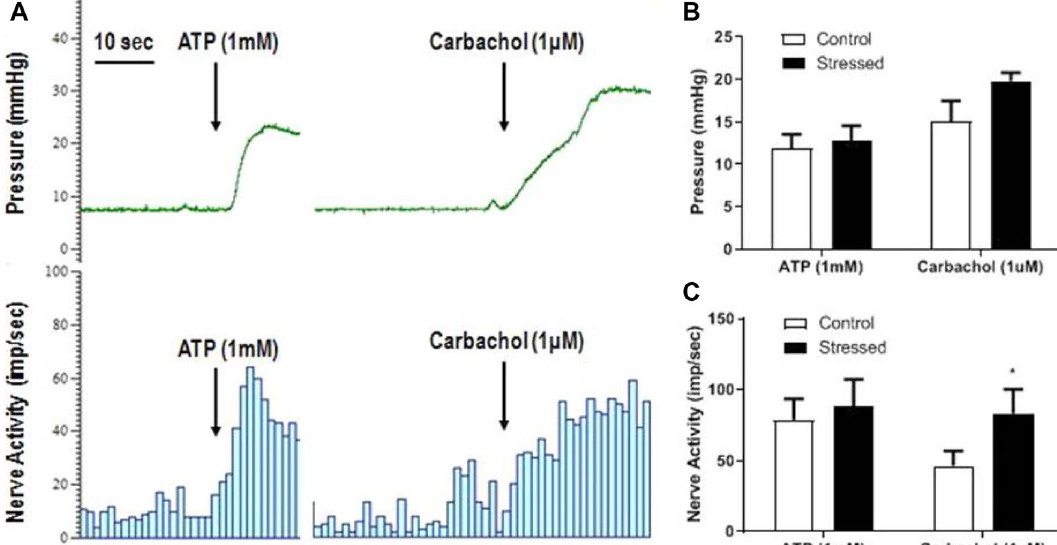
Figure 6. Typical traces showing bladder pressure (mmHg) and nerve activity (imp/s) in response to ATP (1 mM) and carbachol (1 μM) during bladder accommodation ( A ) in a control bladder. Changes in bladder pressure ( B ) and nerve activity ( C ) in control and stressed bladders in response to ATP (1 mM) and carbachol (1 µM), data represented as mean ± SEM, n ≥ 6 and analysed by Students t test (p < 0.05 vs control).